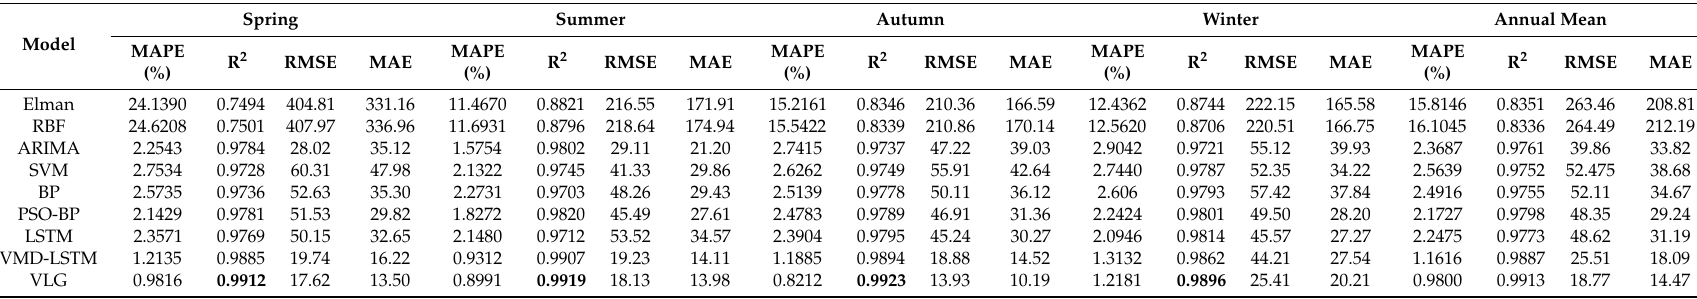
Table 10. The performance indicators of the VLG model based on seasonal data from South Australia compared with other traditional power load forecasting methods. Model